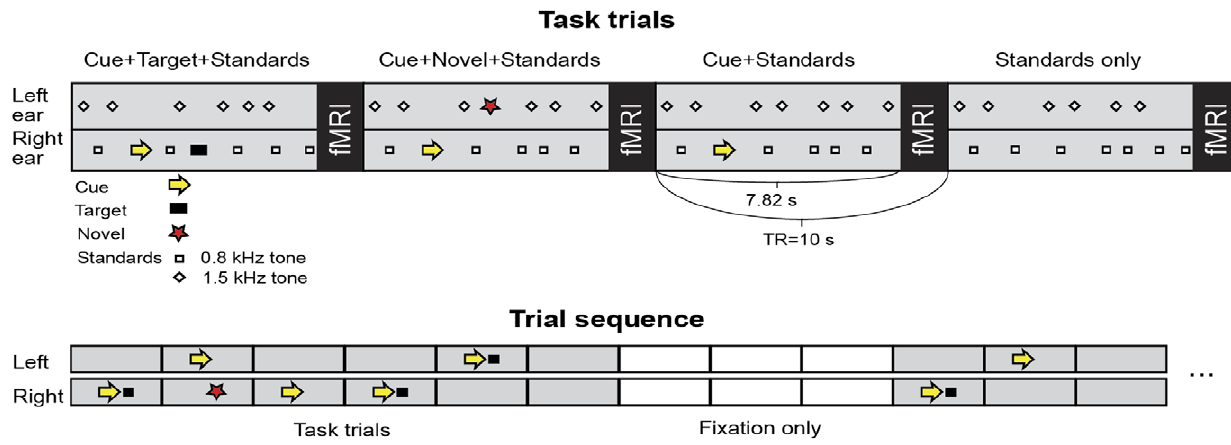
Figure 1. Task and stimuli. In each 10-sec trial, subjects were instructed to wait for a cue in the ear where a subsequent target was likely to appear, and to press a button as quickly as possible after hearing the target. The cues and targets were embedded within dichotic trains of pure-tone standards. Novel sounds, which occasionally occurred opposite to the cued ear, were to be ignored. All stimuli were presented during a 7.82-sec period preceding the fMRI acquisition. Subjects were informed that the sound of the scanner ended the trial (i.e., the scanner noise was a controlled trial-end signal). The proportions of the active trials were as follows: the cue followed by the target (‘‘Cue + Target + Standards’’, 40%), the cue but no target (‘‘Cue + Standards’’, 20%), the cue followed by a novel (‘‘Cue + Novel + Standards’’, 20%), and standard-stimulation only (‘‘Standards’’, 20%). A ‘‘mixed’’ trial-sequence design was used. That is, each period of 6 random-order active trials was followed by a block of 3 silent baseline trials (for example, to allow for quality control of within-subject auditory activations). Finally, withineach trial, the stimulus-onset asynchrony (SOA) was jittered to mitigate expectancy confounds such as omission responses. The overall inter-stimulus interval was 530 ms (during the period between the scans; corresponding to 1.06 sec within one ear, resulting in mean SOA 1.1